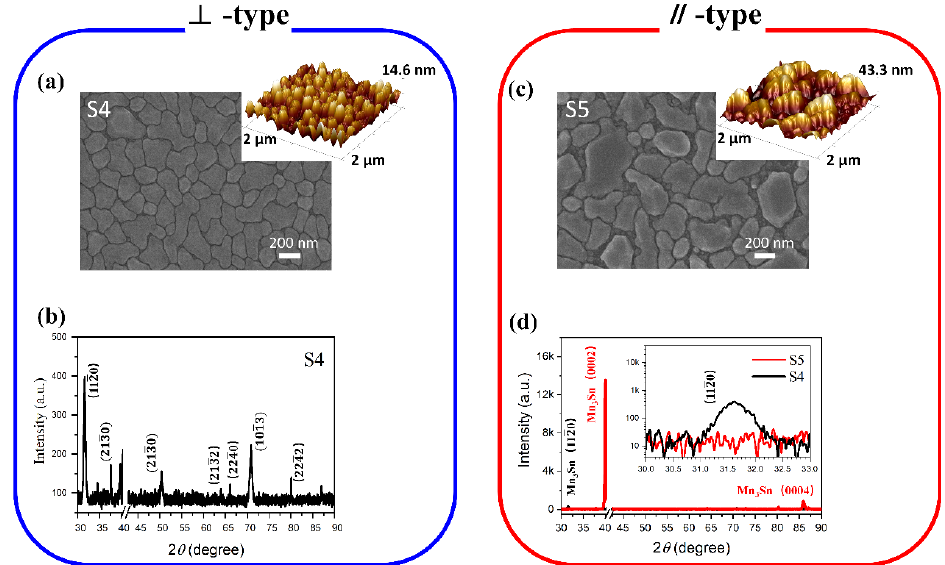
Figure 3. Structural characterization of 40 nm Mn 3+0.53 Sn films. In the blue box: ( a ) SEM image and ( b ) XRD data of S4. Inset of ( a ): 2 μm × 2 μm AFM image. The RMS roughness and the maximum height difference of S4 are 4.12 nm and 14.6 nm, respectively. In the red box: ( c ) SEM images of S5 (inset: surface AFM images, 2 μm × 2 μm). ( d ) XRD patterns of S4 and S5 in the 30–90° range. Inset: XRD at 30–33° with a logarithmic ordinate. The RMS roughness is 13.2 nm, and the maximum height difference is 43.4 nm.